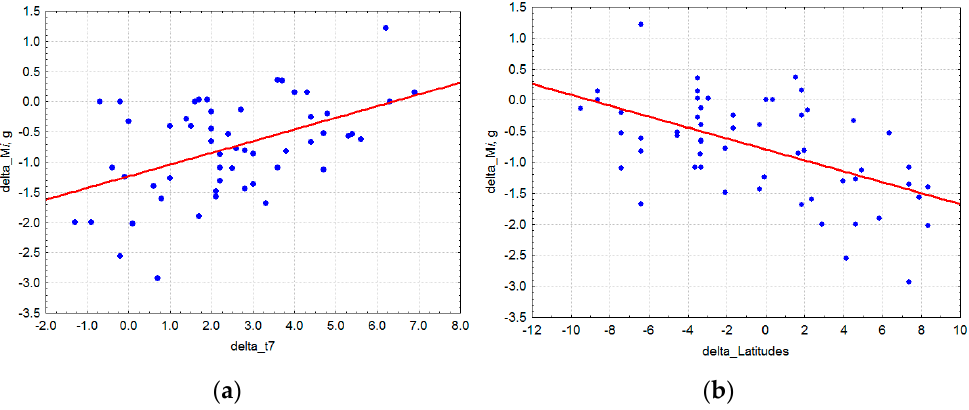
Figure 8. The dependence of the seed mass provenance differences and local seed mass ( Δ M i ) in measurement years 1999–2003 and 2010 in the Boguchany test site (the genetic component) on the July temperature difference in the measurement year at Boguchany and the multi-year mean of provenance ( a ) and the difference of Boguchany latitudes and provenance ( b ).